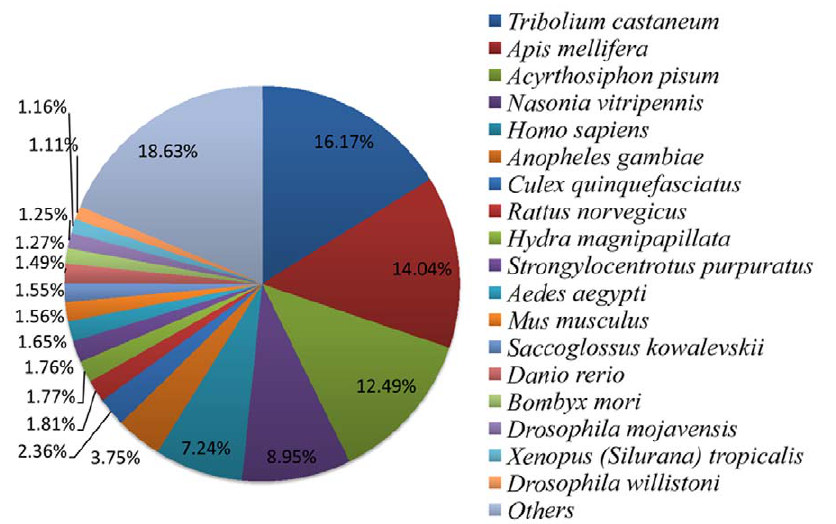
Figure 2. Species distribution of unigene BLASTX results against the NCBI-NR protein database with a cutoff E value , 10 2 5 . Different colors represent different species. Species with proportions of more than 1% are shown.